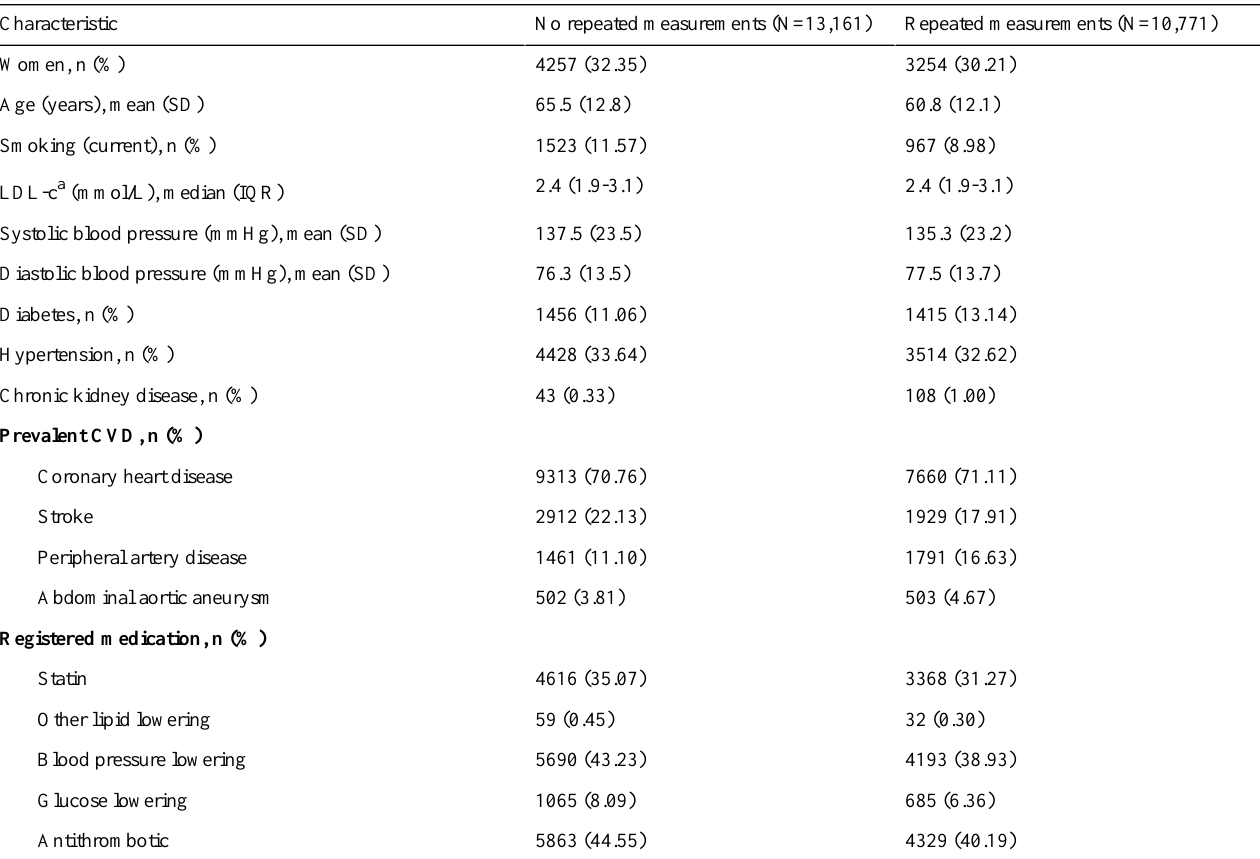
Table 1. Baseline characteristics for cardiovascular disease (CVD) patients at first measurement in strata of presence of repeated